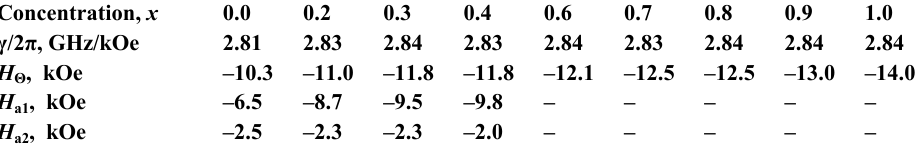
Table 1. Magnetomechanical ratios and MCA fields of the Ba 3 Co 1.5+ х Ti х Fe 24.5-2 х O 41 (0.0 ≤ х ≤ 1.0) .